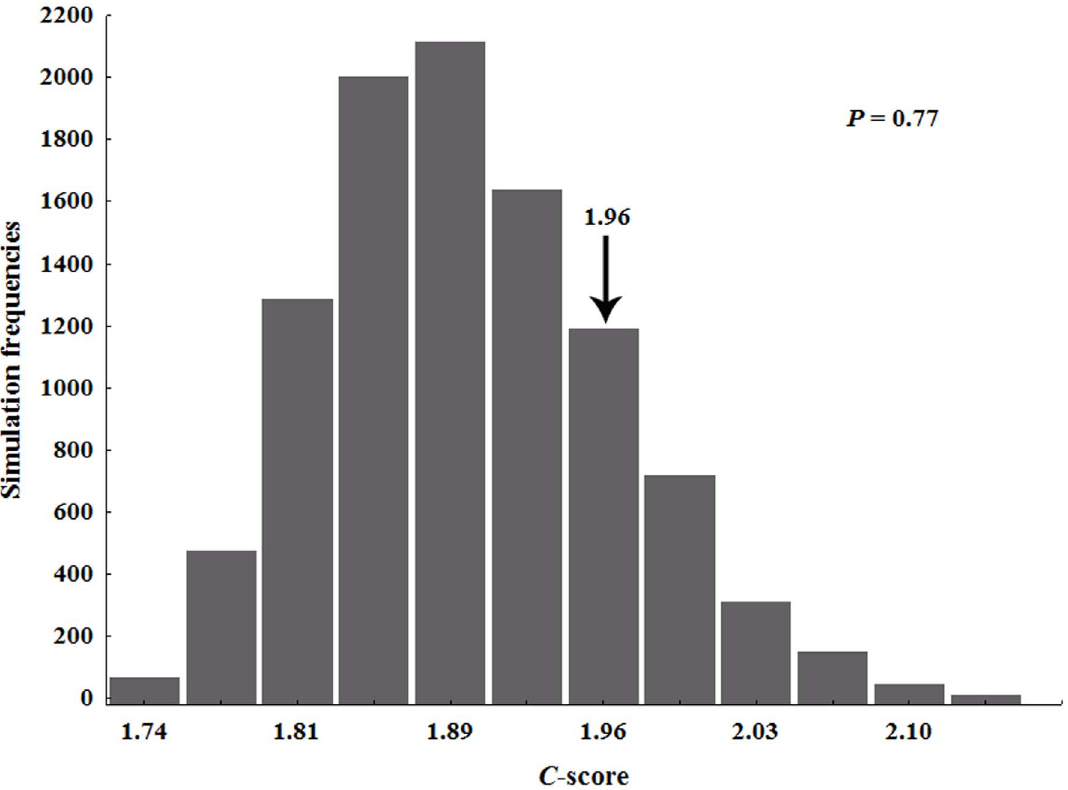
Figure 2. Frequency distribution of checkerboard C -scores obtained from 10,000 simulations produced by randomizations of titanosaurian assemblages. Arrow indicates the observed mean and P is the probability of the observed mean to be statistically greater than that expected.